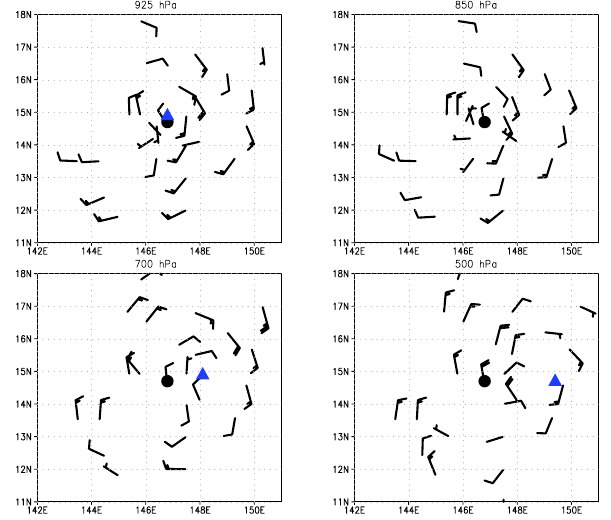
Figure 2. Four-panel plot of wind barbs from the dropwindsonde observations in the co-moving frame for Nuri 1. Levels plotted are 925hPa (a) , 850hPa (b) , 700hPa (c) , and 500hPa (d) . In this figure and Fig. 3, the winds are in standard convention for wind barbs (kt – knot), rather than the SI units used in the remained of the paper. A full wind barb denoted 10kt and each half barb is 5kt. The filled circle represents the 850hPa dropwindsonde-derived cyclonic circulation center and the filled triangles are the circulation centers at the indicated pressure level. The abscissa is longitude and the ordinate is latitude.